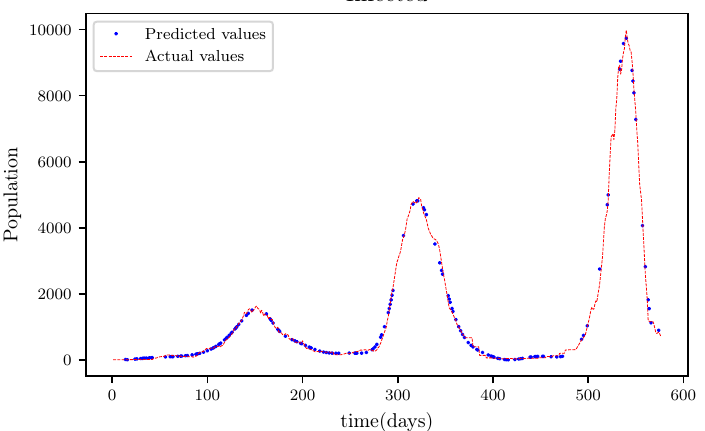
Figure 15. This graph shows a comparison of the predicted values of susceptible population and the actual data of the susceptible population for a 530 data points.